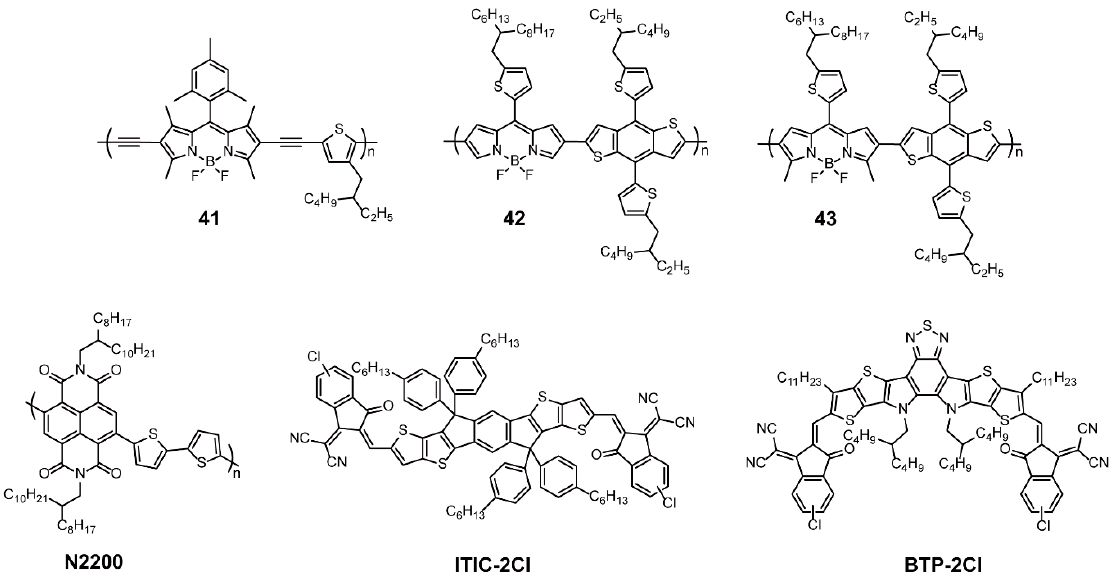
Figure 14. Chemical structures of polymers 41 – 43 and non-fullerenes N2200, ITIC-2Cl, and BTP-2Cl (Reproduced with permission from Reference [76]. Copyright @ 2018, American Chemical Society. Reproduced with permission from Reference [77]. Copyright @ 2019, American Chemical Society. Reproduced with permission from Reference [78]. Copyright @ 2019, Royal Society of Chemistry).